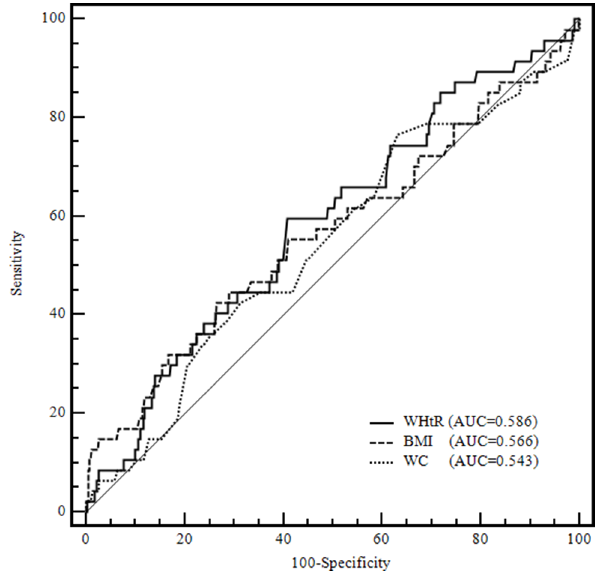
Figure 2. Prediction of ischemic stroke by receiver operating characteristic (ROC) curves for WHtR, BMI and WC. WHtR, waist- to-height ratio; BMI, body mass index; WC, waist circumference.